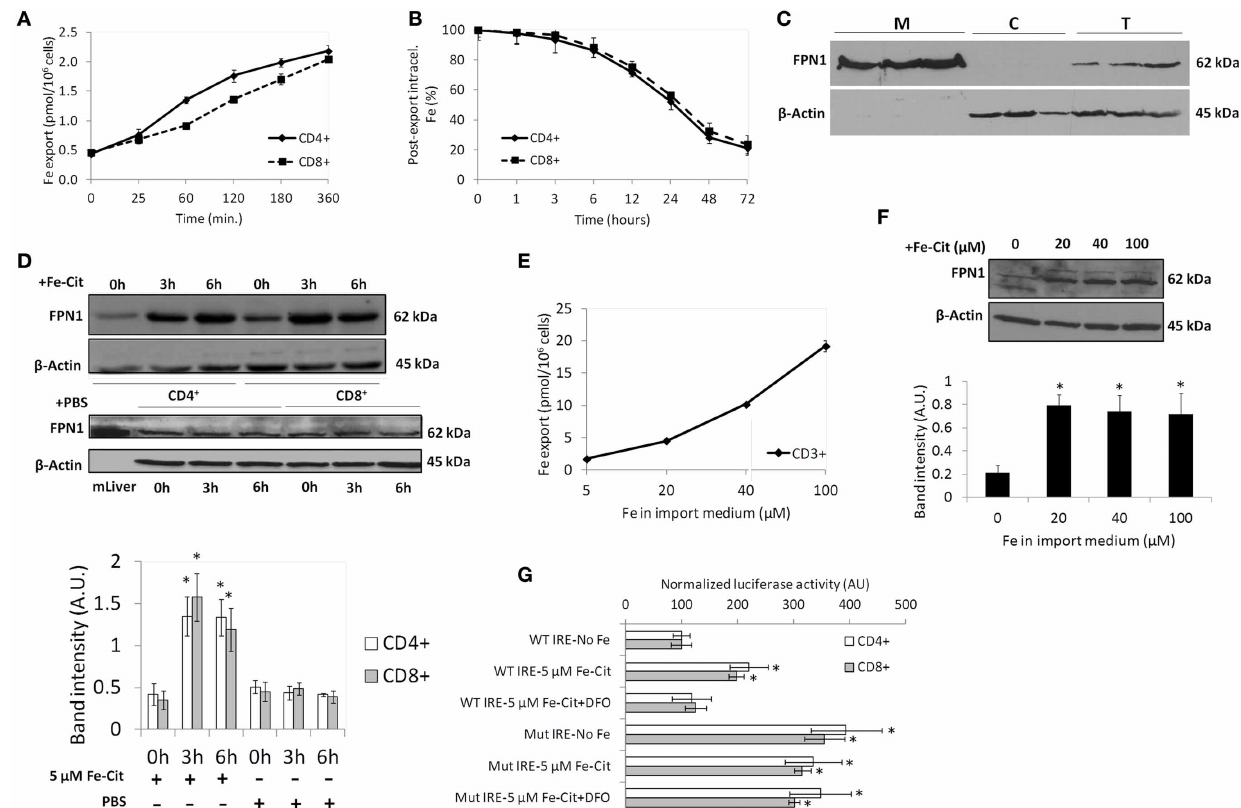
population and experimental condition. (E) Dose-dependent iron export by T lymphocytes. Each point is the mean of two experiments with two replicates each. (F) Western blot quantification of FPN1 expression in T lymphocytes incubated with different Fe-citrate concentrations. β -actin expression was used as loading control. Images are representative of three experiments without significant inter-experimental variation. Bottom panel: Scanning densitometry of FPN1 Western blot. Data are normalized for β -actin levels and are expressed as arbitrary units (AU). ∗ P < 0 . 05 (One-Way ANOVA) between relative FPN1 levels at 0h and posterior time-points. (G) Involvement of the IRE/IRP system in the NTBI-induced modulation of FPN1 in T lymphocytes. Cells were transfected with a chimeric construct including wild-type (WT) or mutated (Mut) FPN1-IRE and incubated with Fe-citrate (Fe-Cit), Fe-Cit + DFO or RPMI (No-Fe) and the luciferase activity quantified. Each point is a mean value ( n = 3) ± 1 SD. ∗ P < 0 . 05 (One-Way ANOVA) for each experimental condition relative to WT IRE-No Fe